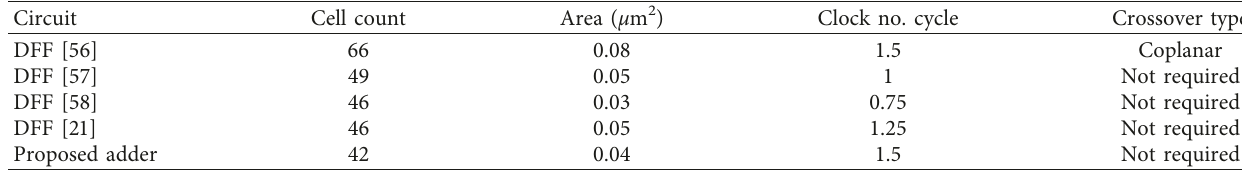
Table 3: Comparison of the proposed D flip-flop with the previous